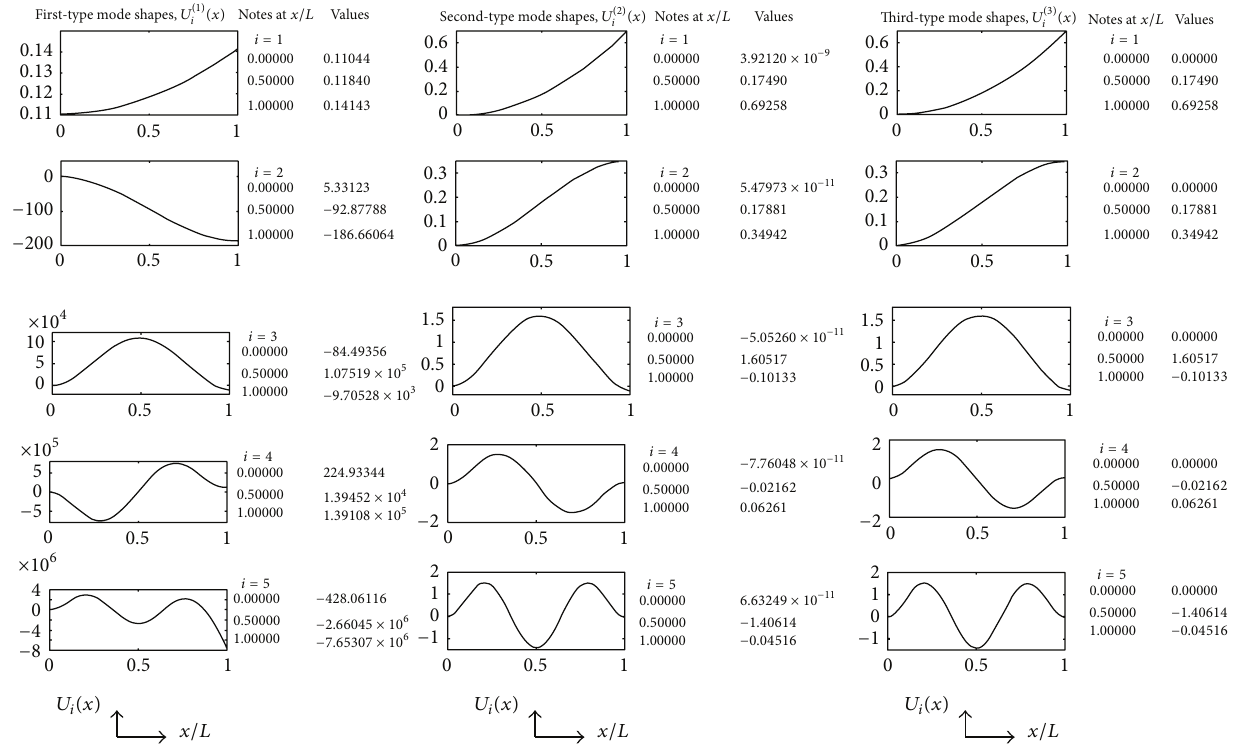
Figure 5: Three types of the first five mode shapes with the combinations of 𝜙 = 4 , 𝑘/𝐿 = 4 , and 𝑑/𝐿 = 0.5 .